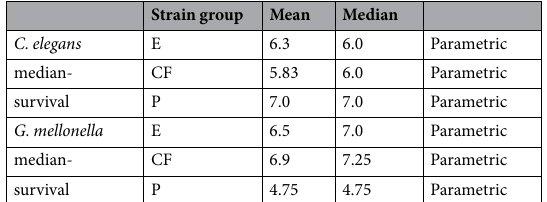
Table 1. Identification of parametric distribution of data by comparison of means and medians of median survival. A difference of 1.0 or lower indicated parametric data. Median-survival rates of P2 and P5 were determined by calculating the intercept as y = 50%.